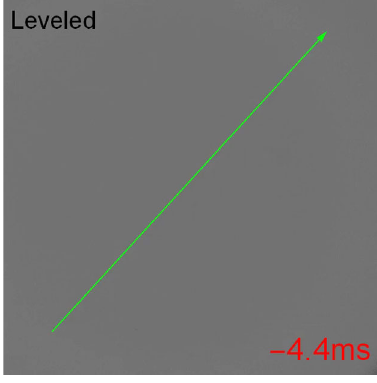
Movie 3. Bottom view for the leveled